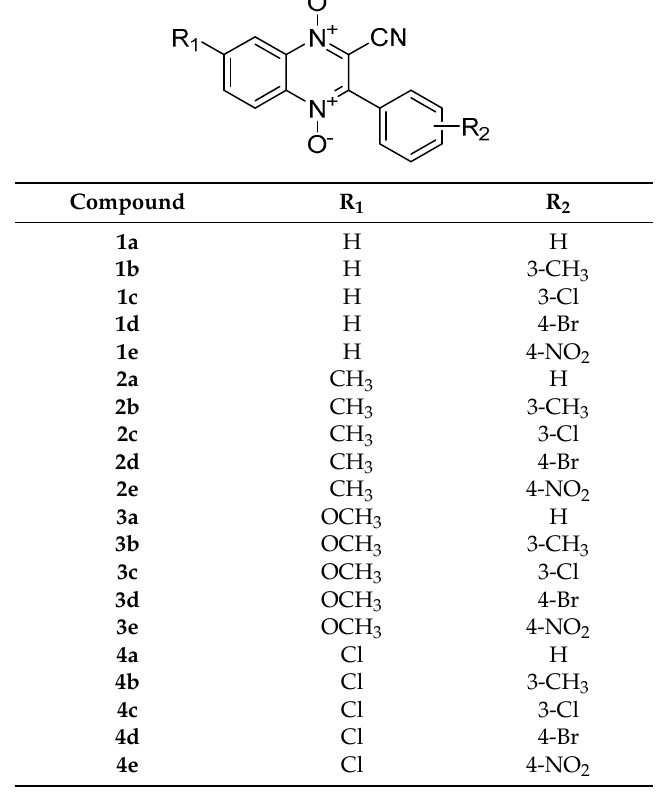
Table 1. Structures of the 3-aryl-quinoxaline-2-carbonitrile 1,4-di- N -oxide derivatives [21].